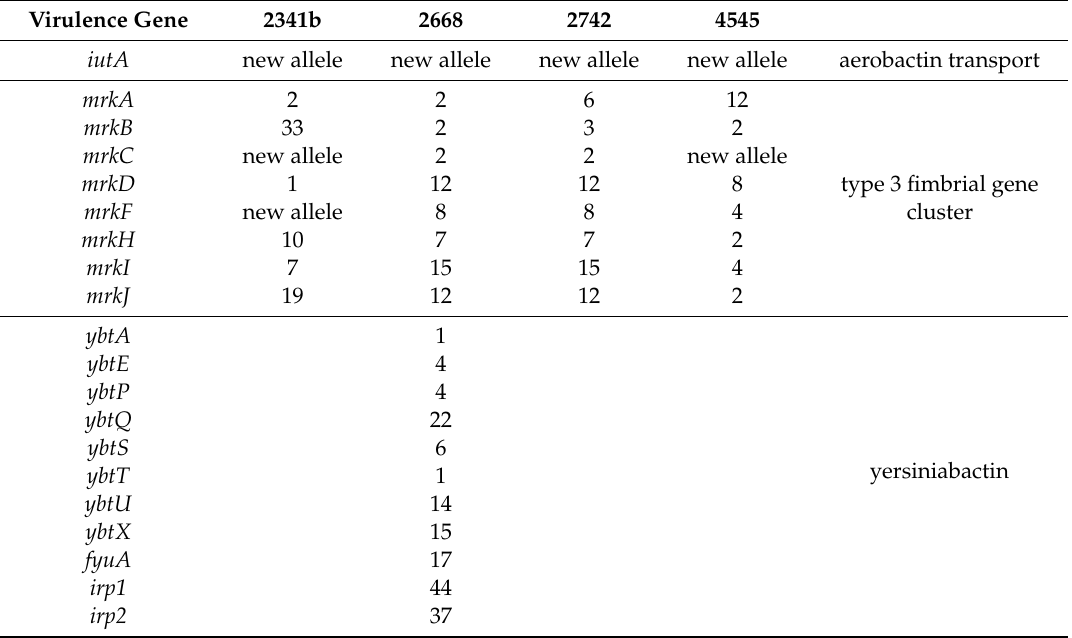
Table 3. Identified virulence factors in four K. pneumoniae isolates. Numbers correspond to the exact alleles